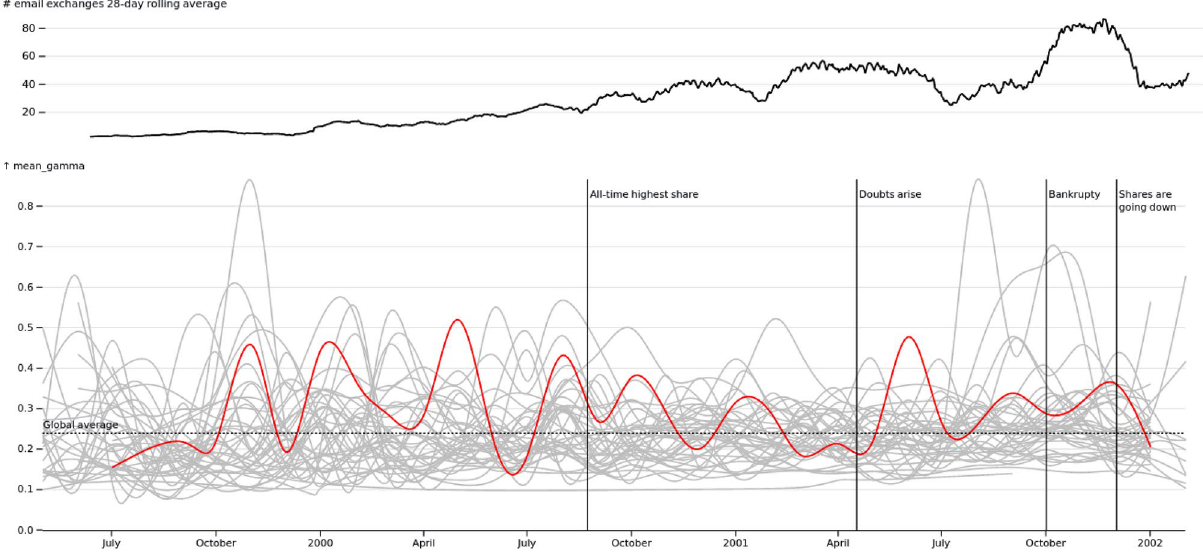
Figure 4. Evolution of topic 25 (mw, ercot, purchase, sale, firm, schedule, short, pge, sell), which is a specialized topic for community